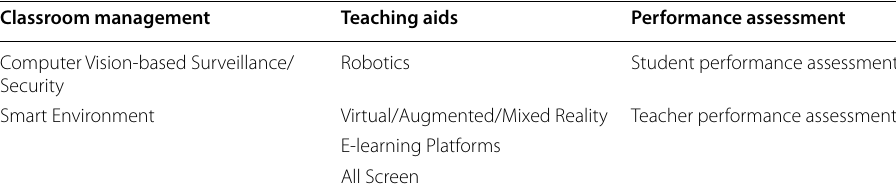
Table 1 Taxonomy of key technologies related to smart classes presented Classroom